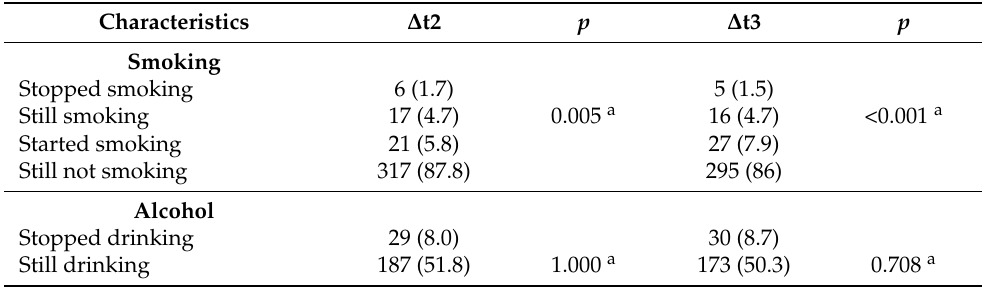
Table 2. Mean change scores of health behaviors and socio-cognitive factors of Lebanese adolescents at the 6 and 12 months